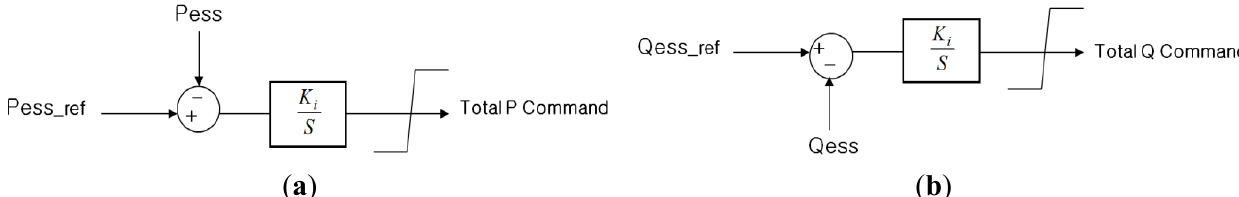
Figure 8. Block diagram of PLL: ( a ) Active power control loop; ( b ) Reactive power control